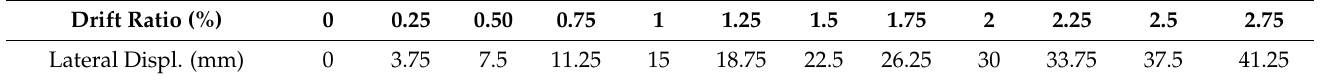
Table 5. Drift ratios and corresponding displacements applied to the tested specimens.